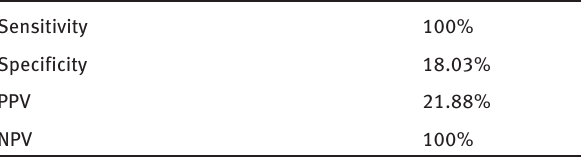
Table 3: Correlation between iPTH levels < 6.3 pg/mL on the first postoperative day and the development of permanent